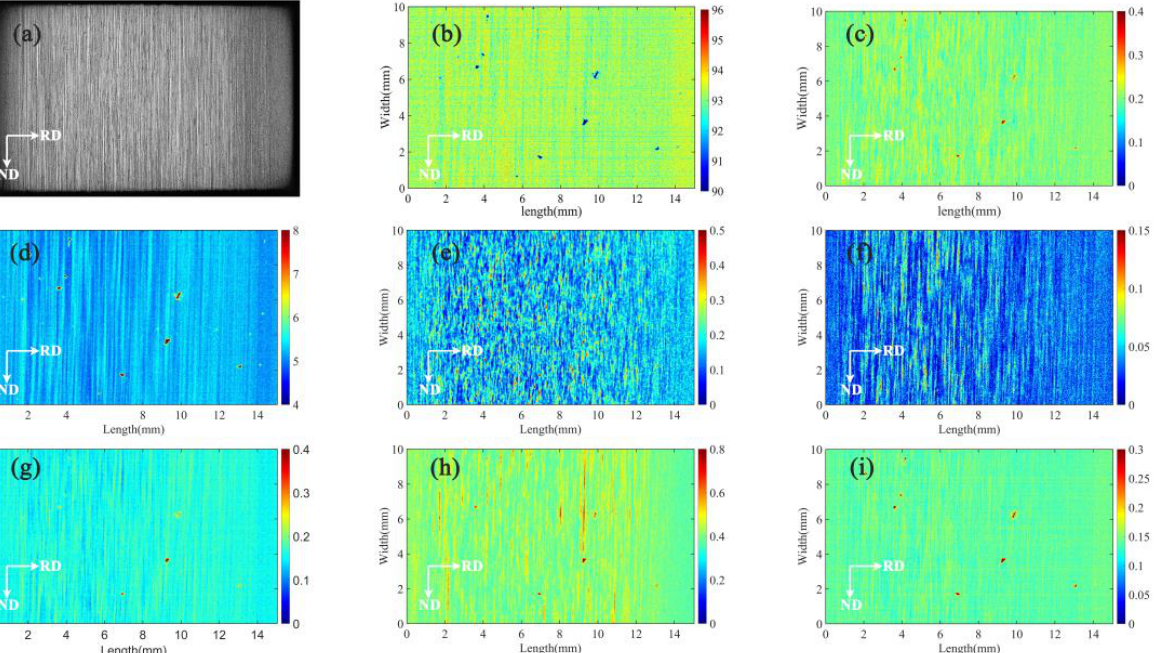
Table 5. Results of statistical distribution analysis of element content.